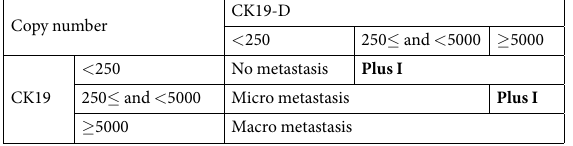
Table 1. Diagnostic strategy for assessing OSNA